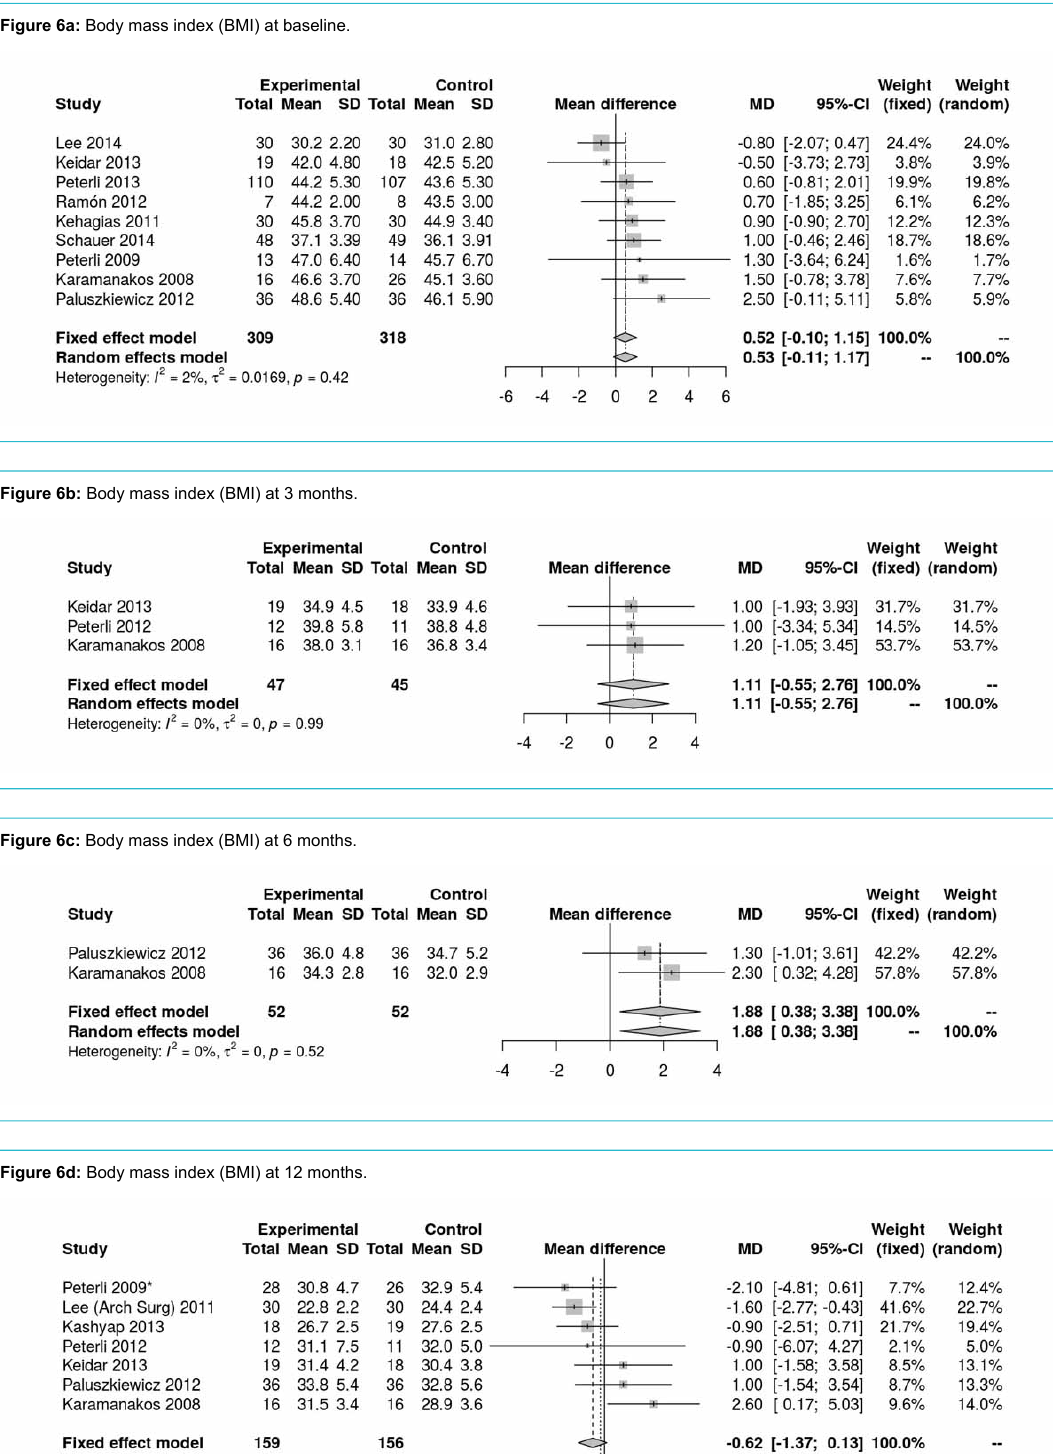
Figure 6a: Body mass index (BMI) at baseline.